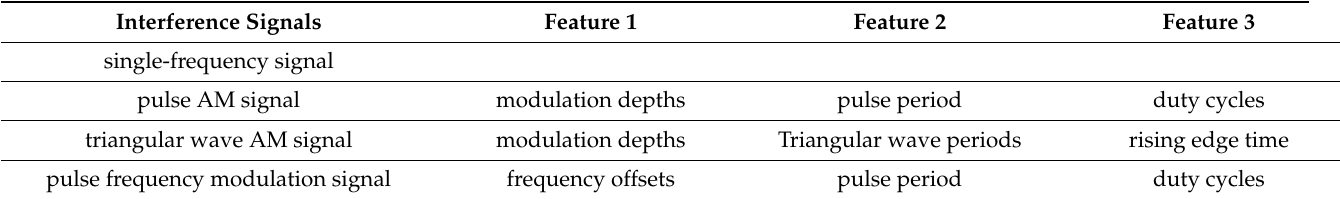
Figure 4. Block diagram of electromagnetic sensitivity experiment of the laser ranging system. Table 1. Types and features of interference signal